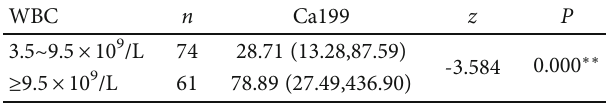
Table 2: Comparisons of Ca199 between the two groups.